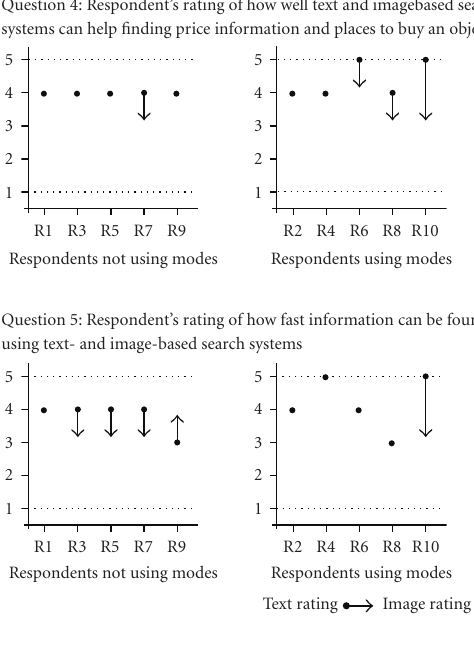
Figure 8: Rating diagrams from